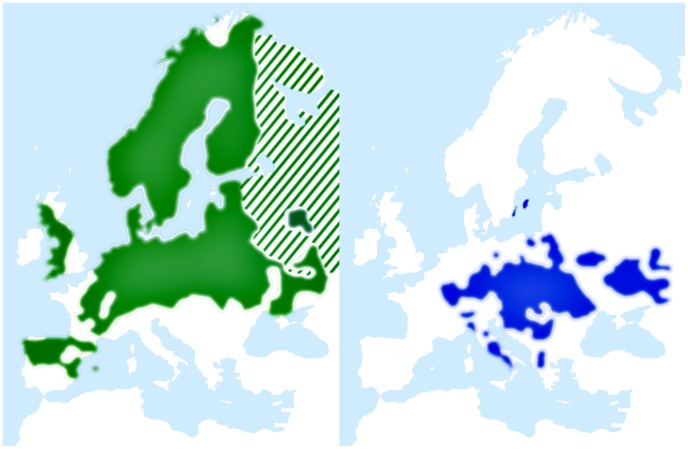
Breeding range distributions of pied flycatcher (green) and collared flycatcher (blue).Maps adapted and redrawn from EBCC (European Bird Consensus Council) Atlas of European Breeding Birds (http://s1.sovon.nl/ebcc/eoa/). Stripes indicate uncertainty of species existence in the area.